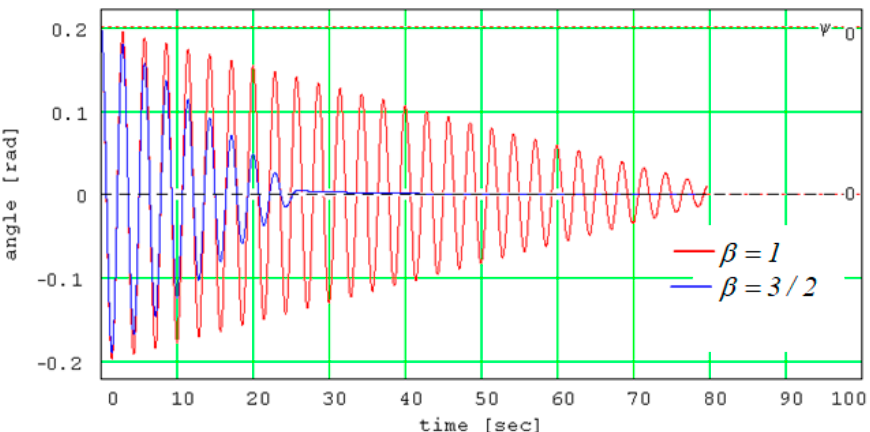
ff erent dependencies of rolling torque.